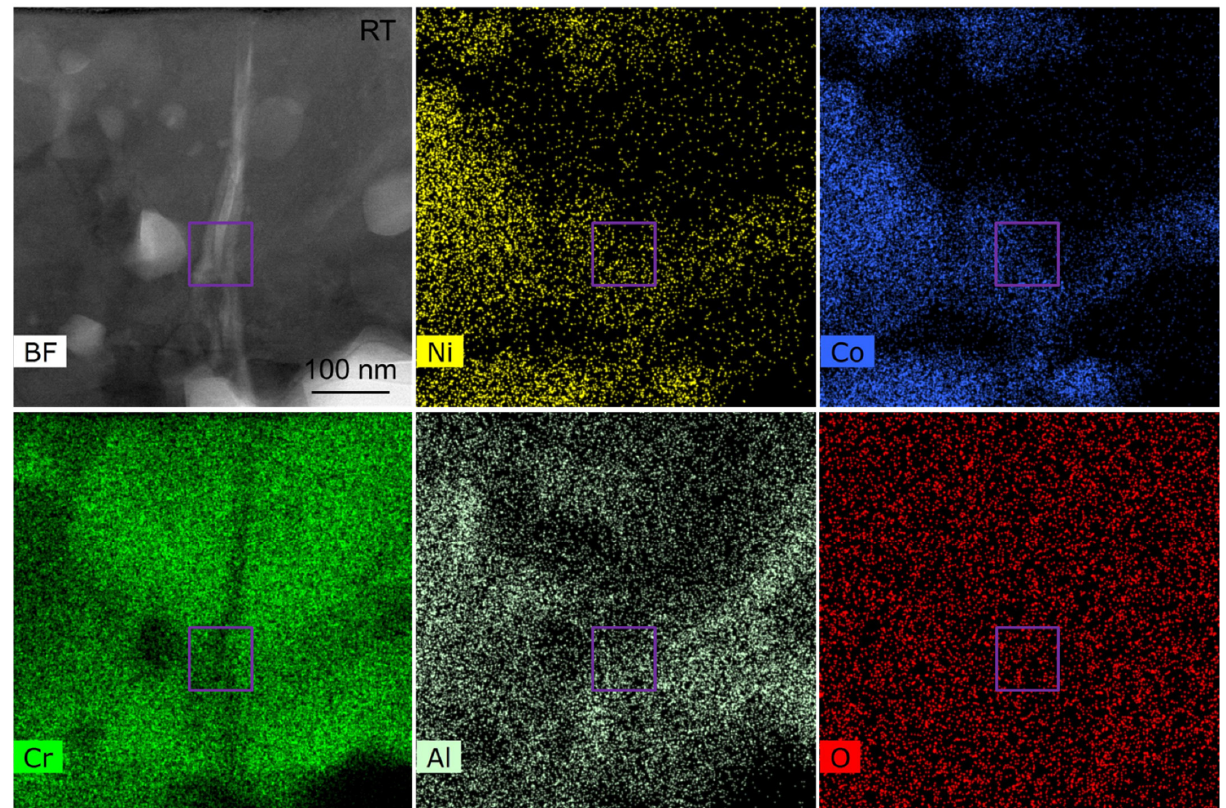
Figure 12. STEM-EDS maps of the internal region of TGO.